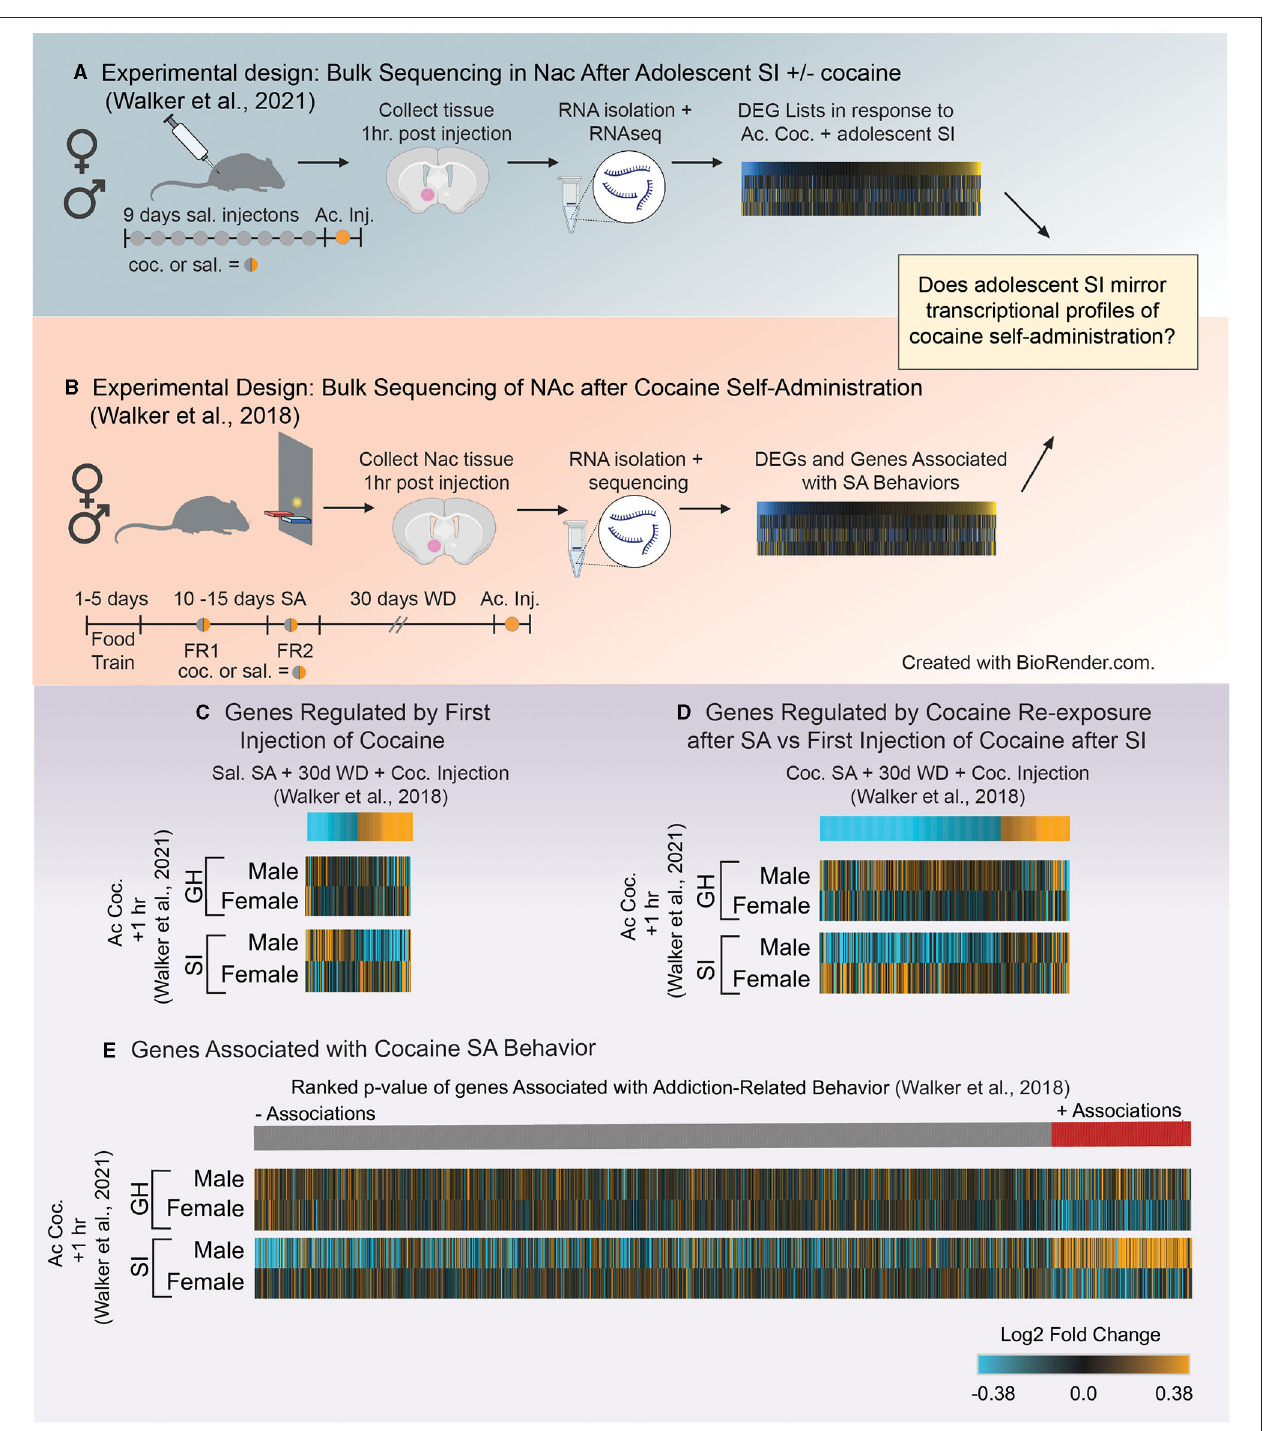
FIGURE 5 | (A) Schematic of experimental design utilized in Walker et al. (121) which investigated how adolescent social isolation disrupts the transcriptomic effects of cocaine in males and females. (B) Schematic of experimental design investigating transcriptional profiles in the NAc after cocaine self-administration from Walker et al. (132). (C,D) Heatmaps of genes altered by different exposure conditions after self-administration (132) compared to expression profiles in group housed (GH) and socially isolated (SI) animals after the first dose of cocaine (121). Expression of genes regulate by the first dose of cocaine after saline self-admin + 30 days of withdrawal (WD) are opposite to those of socially isolated (SI) males after their first dose of cocaine (C) . However, transcriptional profiles of genes regulate by the cocaine re-exposure after cocaine self-admin + 30 days of withdrawal (WD) are reflected in the expression profiles of SI males after their first dose of cocaine